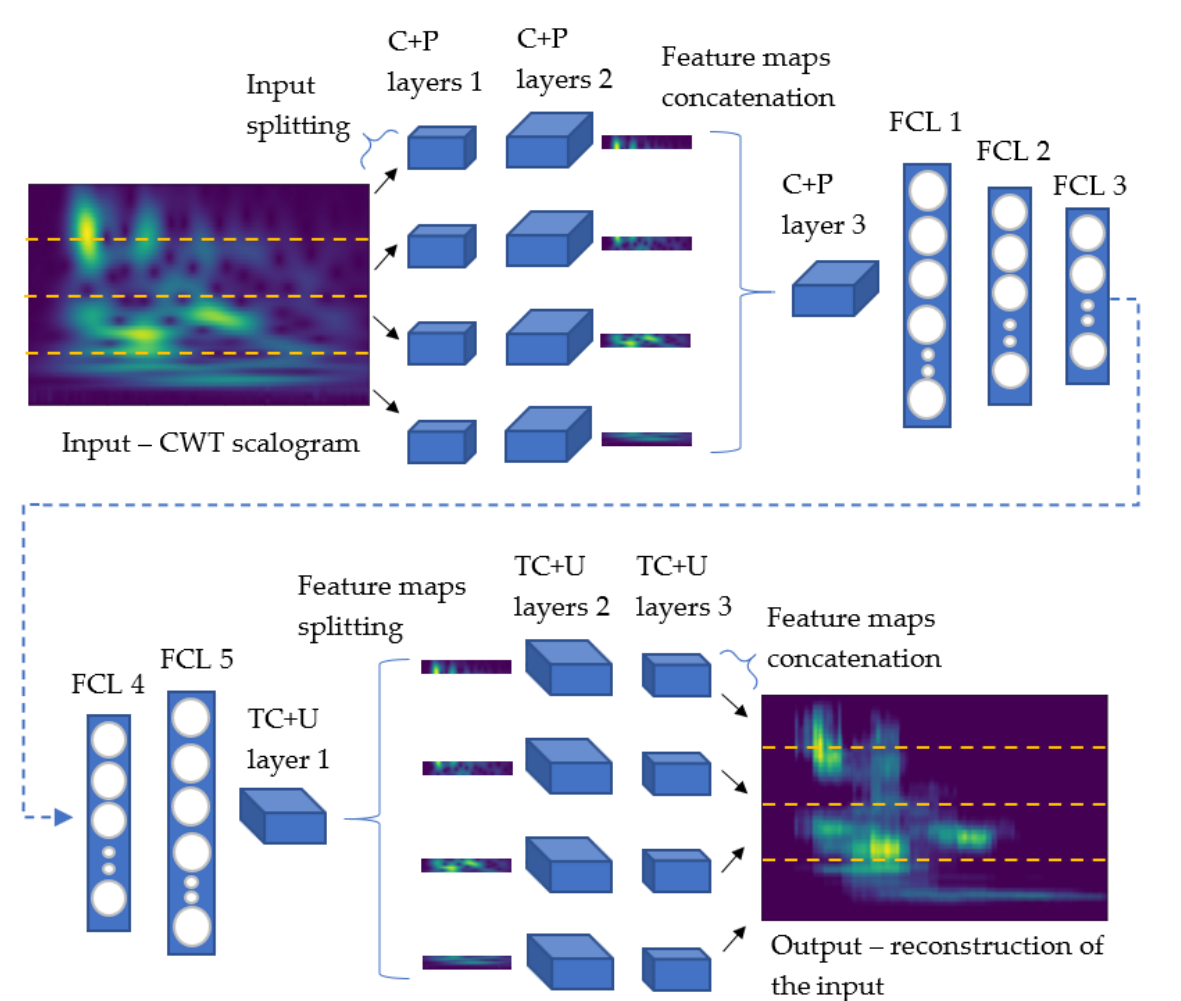
Figure 2. Convolutional autoencoder (CAE) for deep feature extraction.